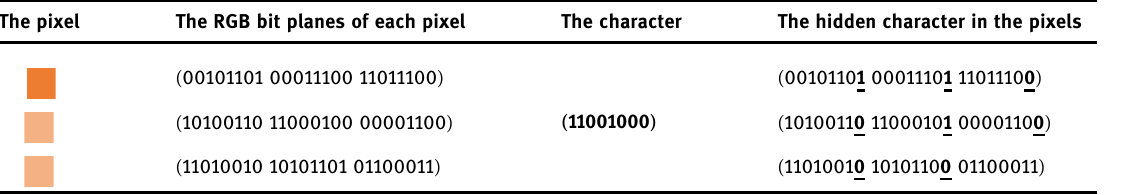
Table 1: LSB method for embedding secret message in an image The pixel The RGB bit planes of each pixel The character The hidden character in the